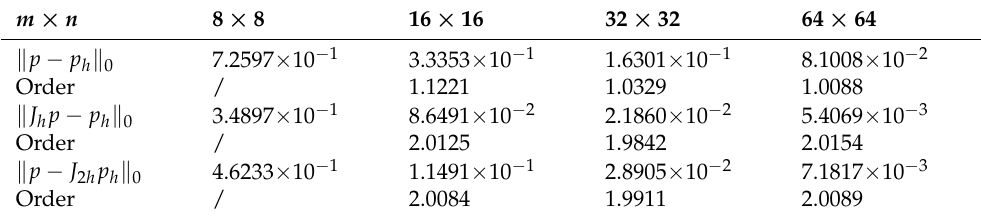
Table 4. The numerical errors and convergence orders at t = 0.6 of p .